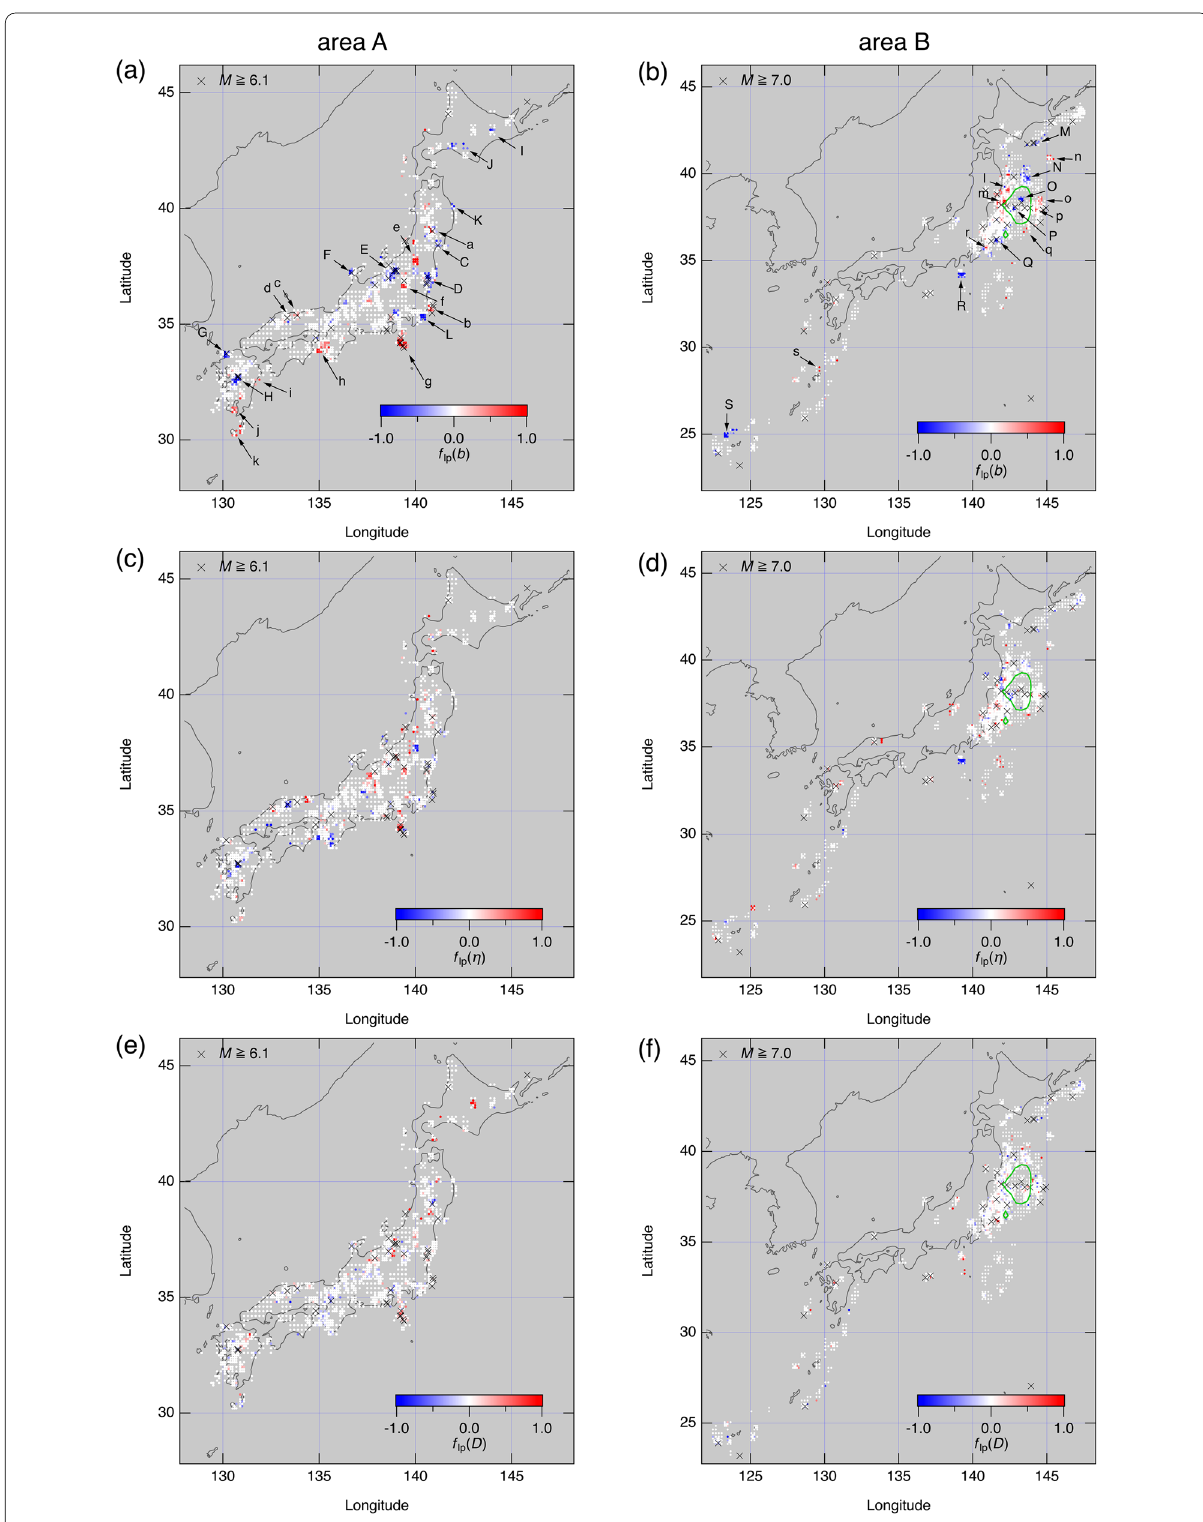
Fig. 7 (See legend on previous